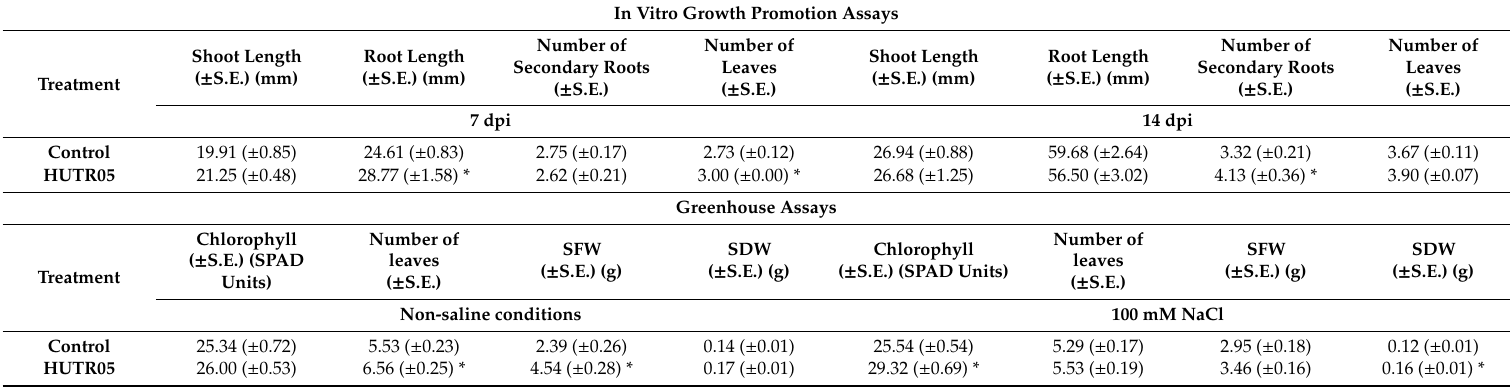
Table 1. Results from in vitro growth promotion assays and from greenhouse growth promotion assays and chlorophyll content, in lettuce inoculated with Rhizobium laguerreae HUTR05